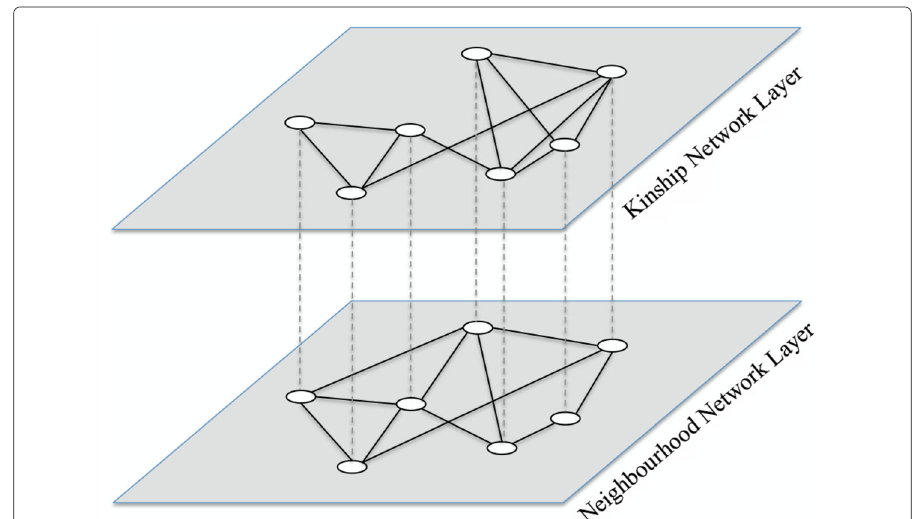
Fig. 3 A two-layer multiplex